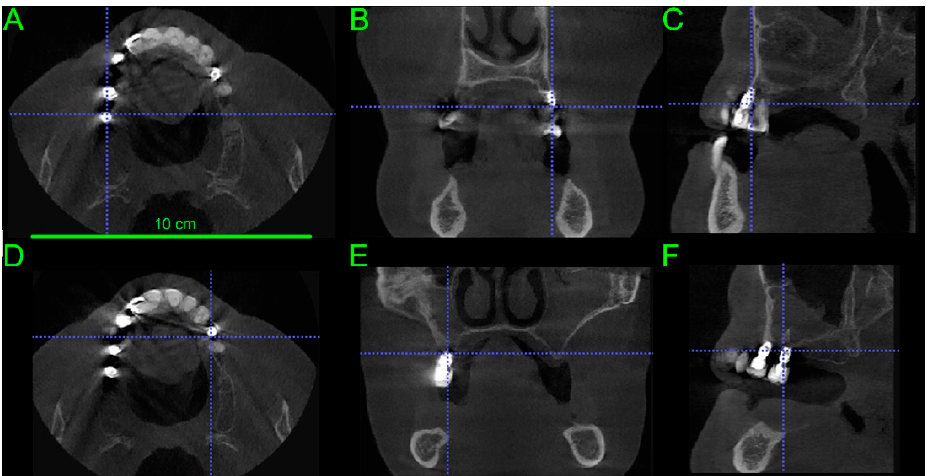
Figure 1. Bone quality determined pre-operatively using CBCT images. Orthogonal views were ac- quired by using 2D basis images for secondary reconstruction of axial ( A , D ), coronal ( B , E ) and sag- ittal ( C , F ) views. Significant buccal bone loss is apparent on the left side (upper panel), and the right side (lower panel).